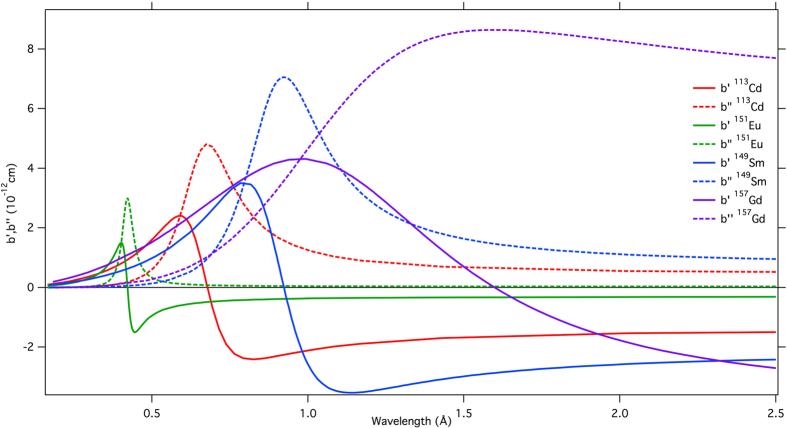
Calculated values of b’ and b” for E = 178 meV neutron resonance of 113Cd, 151Eu, 149Sm and 157Gd derived from Breit-Wigner formula with the scattering length  (Er is the resonance energy, Γ is the total width of the resonance Γn is the width of resonance for re-emission of the neutron with its original energy, k = 2π/λ is the wavenumber and R the nuclear radius).Resonance parameters Er, Γn, Γ were taken from44.